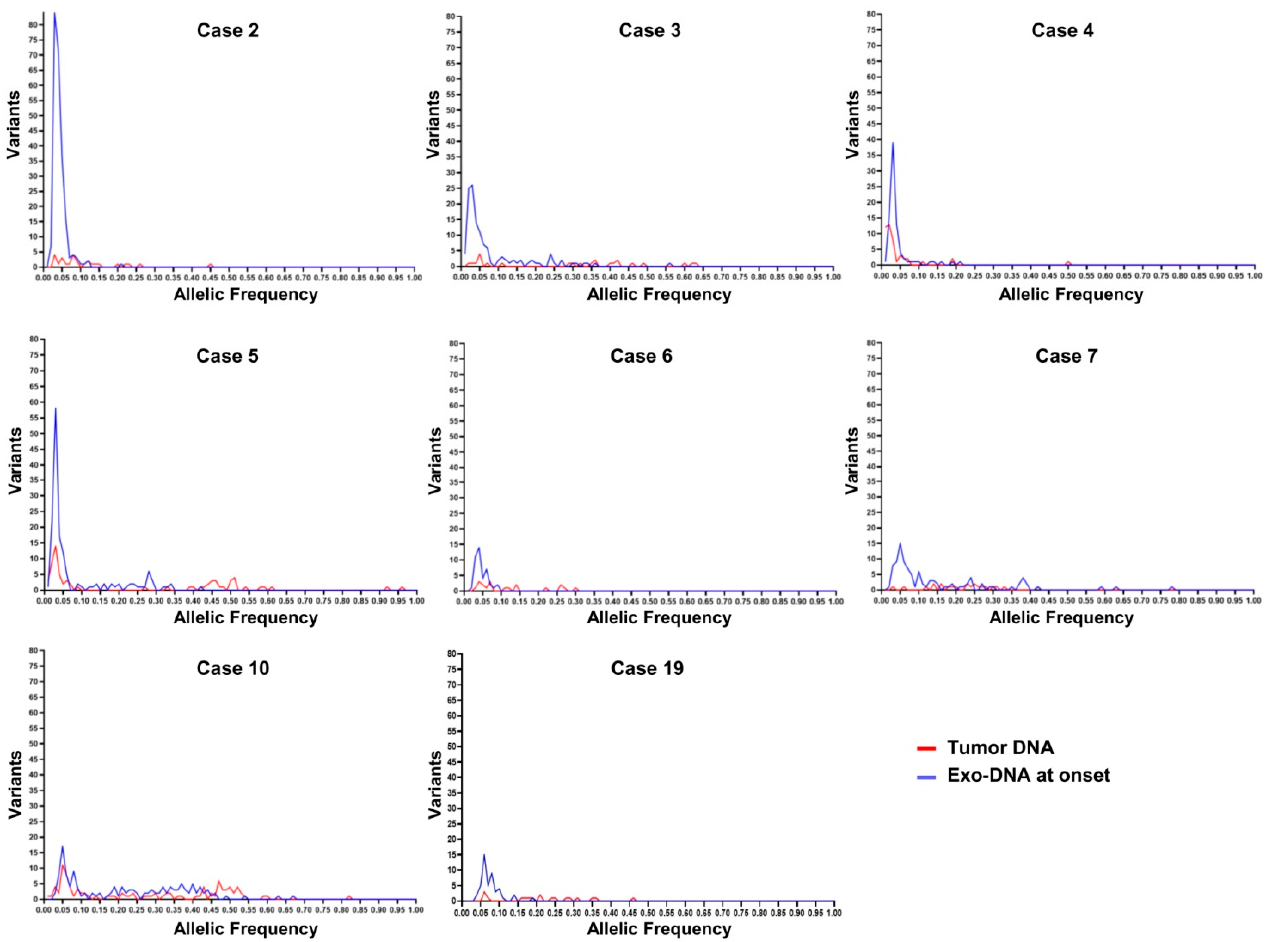
Figure 4. Somatic SNVs frequency in neuroblastoma (NB) cases with exo-DNA at onset and tumor DNA.